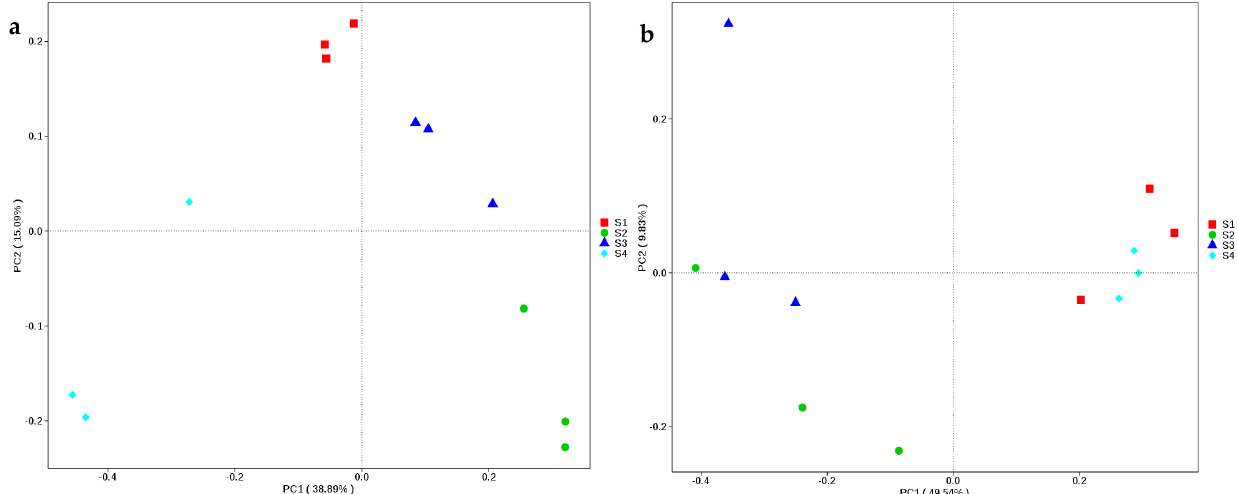
Figure 2. Non-metric multi-dimensional scaling based on Bray-Curtis assessment of bacterial ( a ) and fungal ( b ) diversities in whole-plant corn silages (n = 3). S1, silage collected from Erdos; S2, silage collected from Baotou; S3, silage collected from Ulanqab; S4, silage collected from Hohhot.